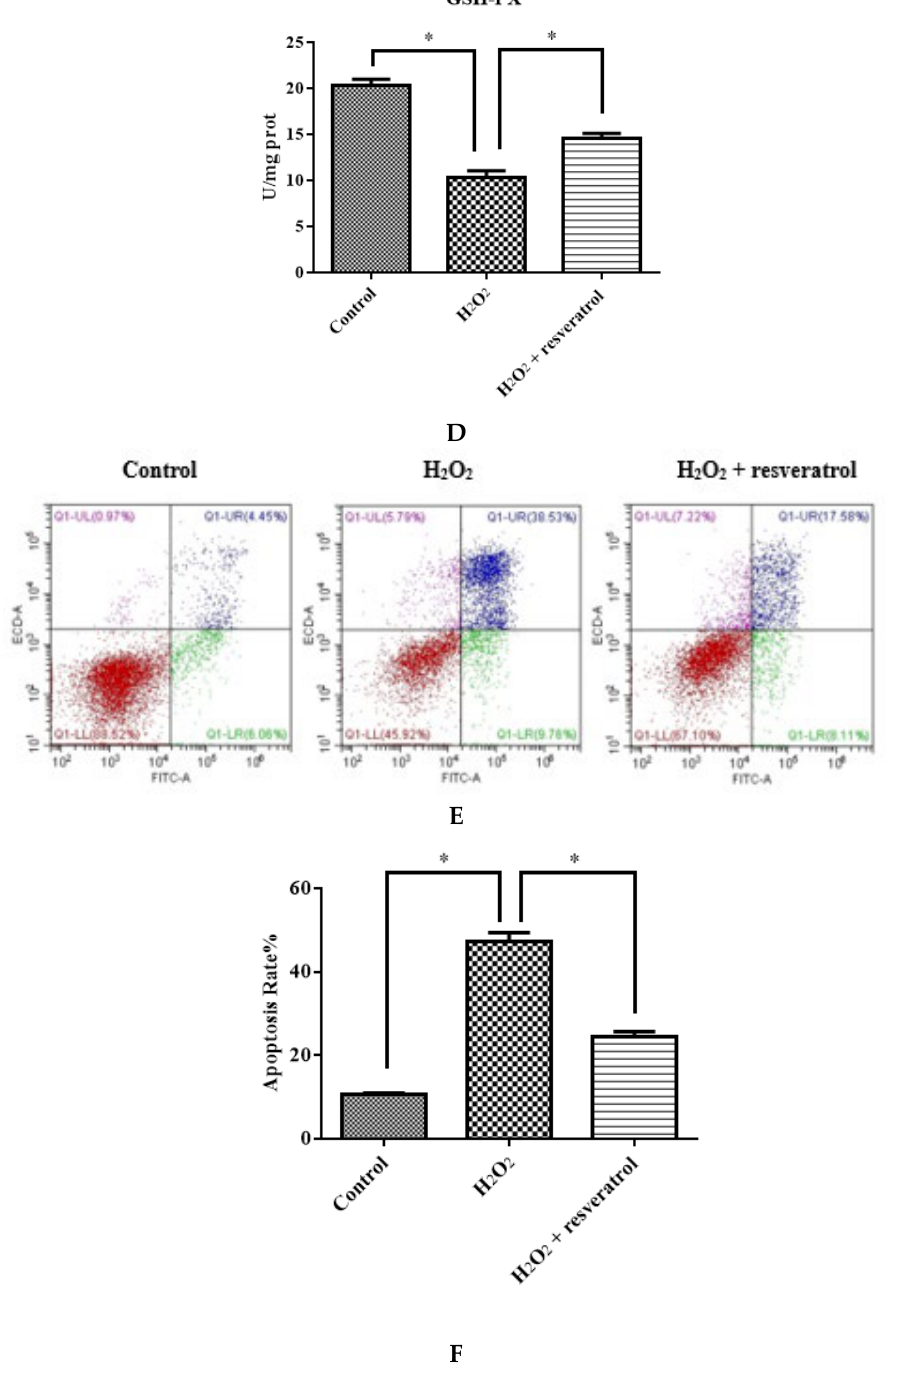
Figure 6. IDECs were pretreated with 5 μM resveratrol and then cocultured with 400 μM H 2 O 2 for 6 h. ( A ) The ROS production in IDECs treated with different groups was determined by 2′,7′ - dichlorofluorescein diacetate (DCFH-DA). ( B ) The activities of MDA in IDECs were detected by commercial kits. ( C ) The activities of CAT in IDECs were detected by commercial kits. ( D ) The activities of GSH-PX in IDECs were detected by commercial kits. ( E ) Apoptosis cells were analyzed by flow cytometry using Apoptosis Detection Kit. ( F ) The data were analyzed through one-way ANOVA and are expressed as the mean ± SE ( n = 3). * p < 0.05 compared to H 2 O 2 group.